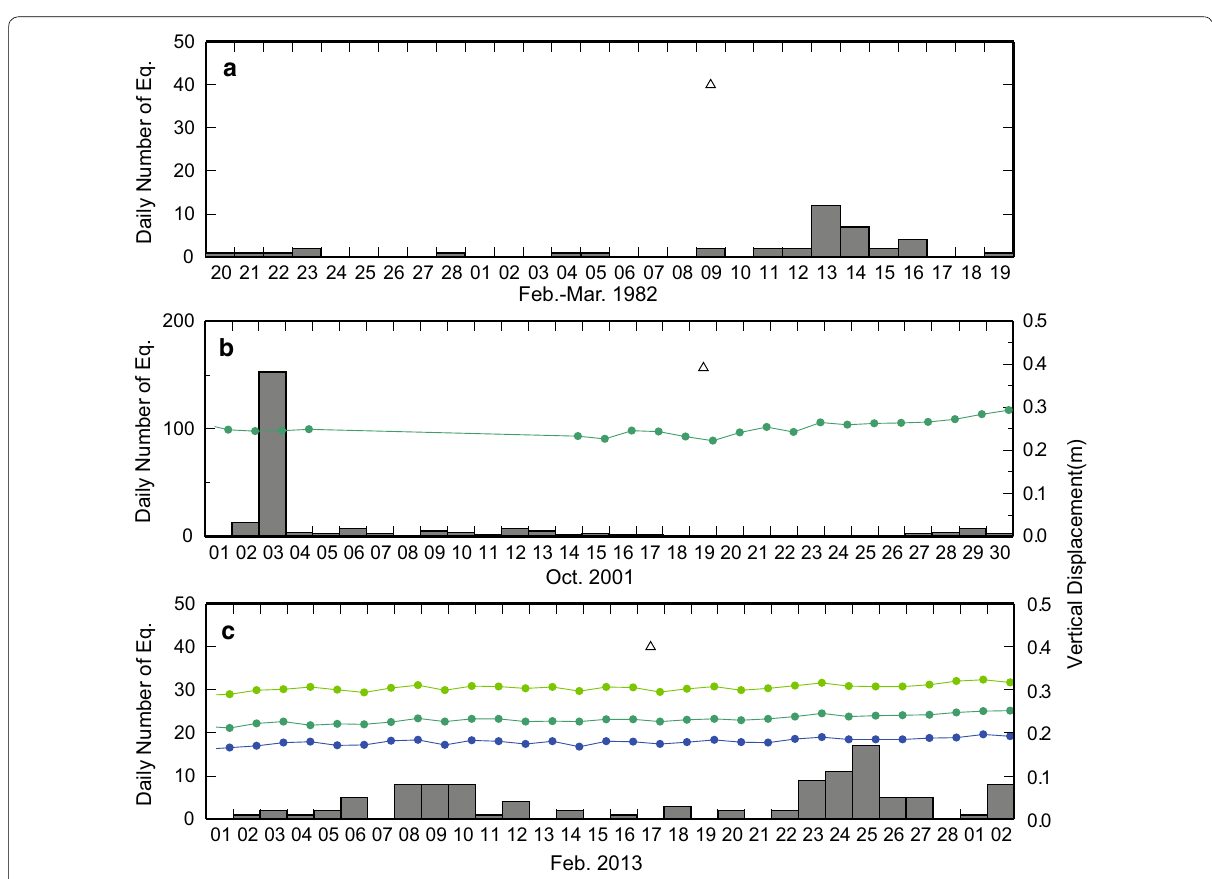
Fig. 6 The daily number of earthquakes and vertical movement at Motoyama before and after phreatic eruptions were not accompanied by precursors. a The eruption on March 9, 1982; b the eruption on October 19, 2001; c the eruption on February 17, 2013. The green and blue curves denote vertical movement at GNSS observation stations. The white triangles show the occurrence times of the